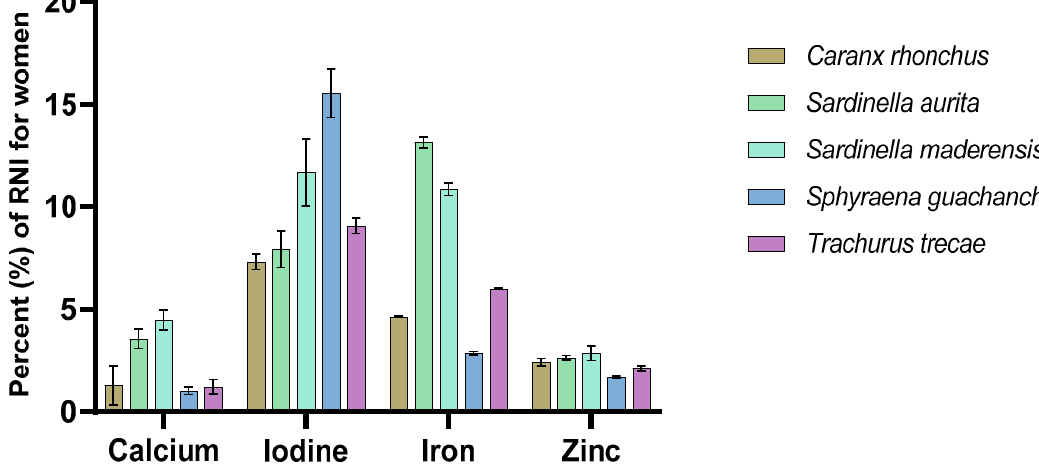
Figure 1. The contribution of calcium, iodine, iron, and zinc (in percentage) to the recommended nutrient intake (RNI) for women of reproductive age, from the consumption of a 50 g portion fillet of the various fish species.